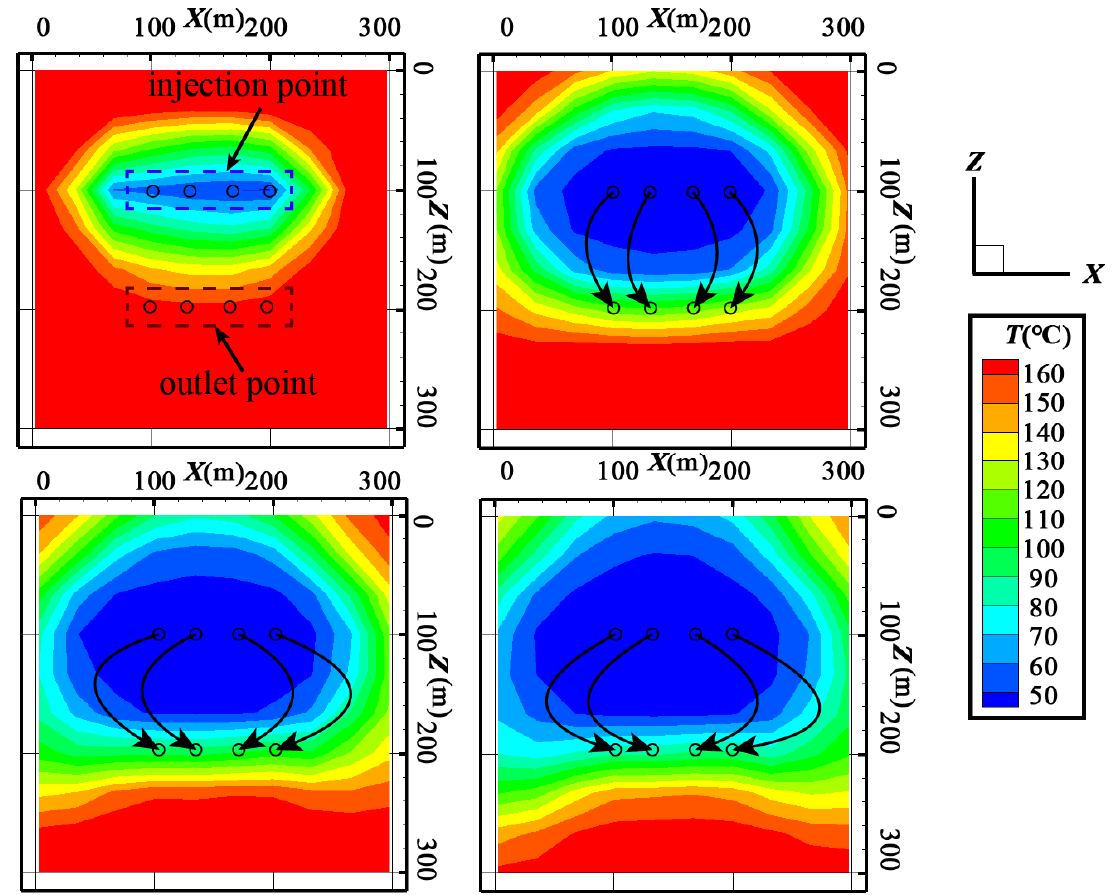
Figure 16. Temperature distribution for the horizontal wells.